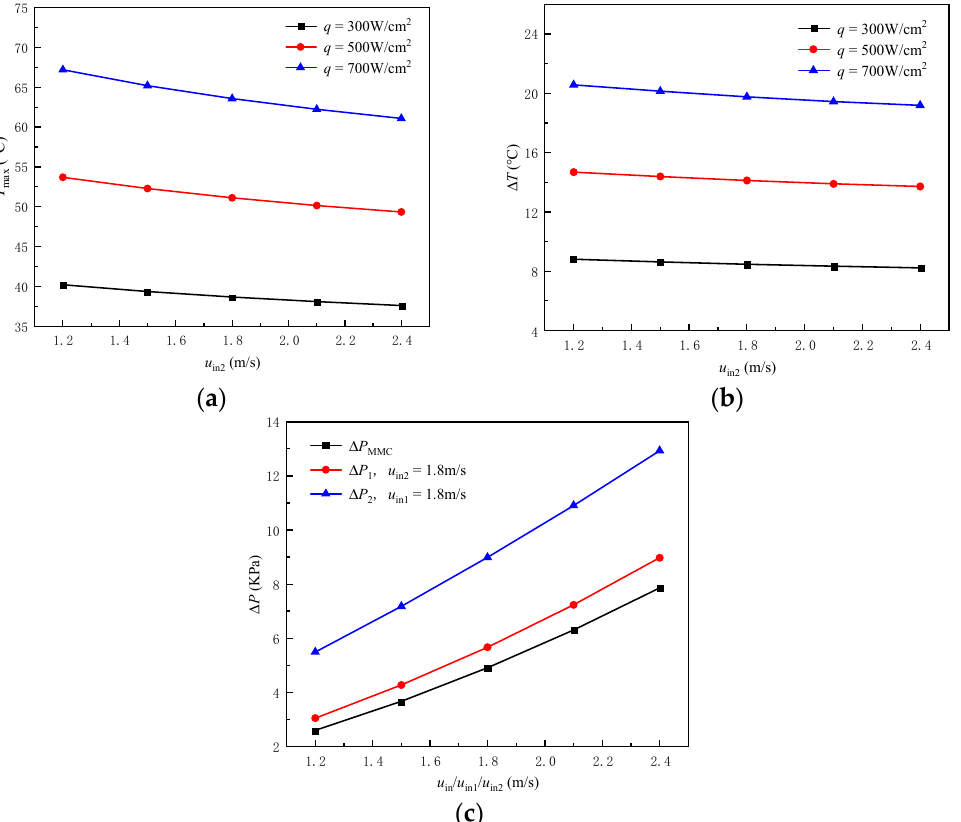
Figure 11. Heat transfer performance of MDMC at different inlet velocities. ( a ) T max ; ( b ) Δ T ; ( c ) Δ P .